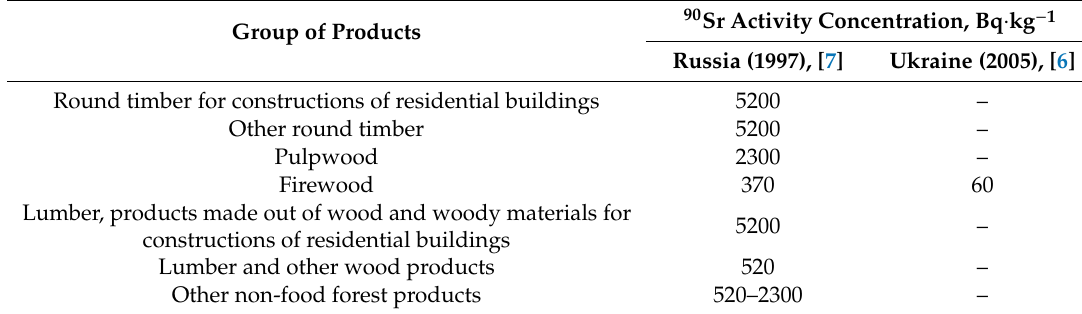
Table 1. Existing restrictions for forest products use according to 90 Sr